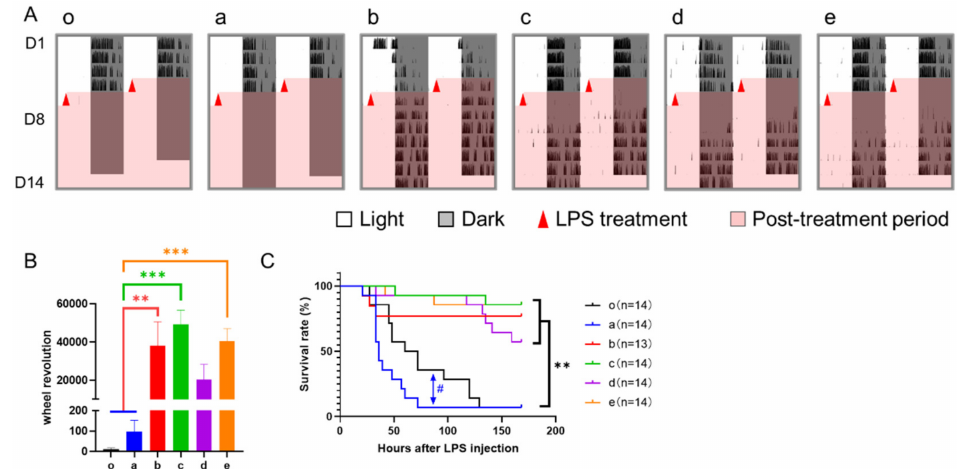
Figure 5. Effect of 6-h TRFs on behavior and health in mice treated with a 12-h phase shift and LPS injection. ( A ) Representative double-plotted actograms of wheel running activity after LPS treatment; ( B ) Total number of wheel revolutions after LPS injection. *** p < 0.001; ** p < 0.01, one-way ANOVA with Tukey’s multiple comparisons test. ( C ) Effect of TRF on survival of septic mice. ** p < 0.01; # p < 0.1, Log-rank